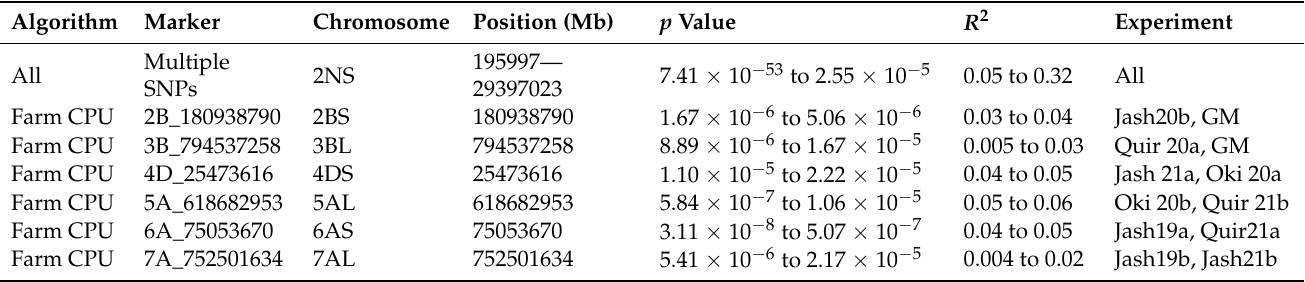
Table 3. Markers significantly associated with wheat blast resistance through genome wide associa- tion mapping using mixed linear model (MLM), multi locus mixed model (MLMM) and fixed and random model circulating probability unification (FarmCPU).